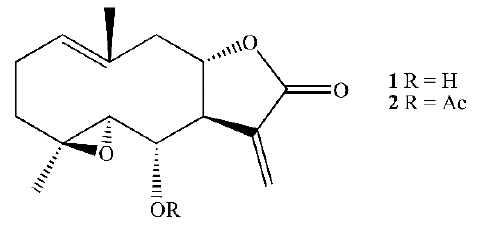
Figure 1. Structure of spiciformin ( 1 ) and its acetate ( 2 ).